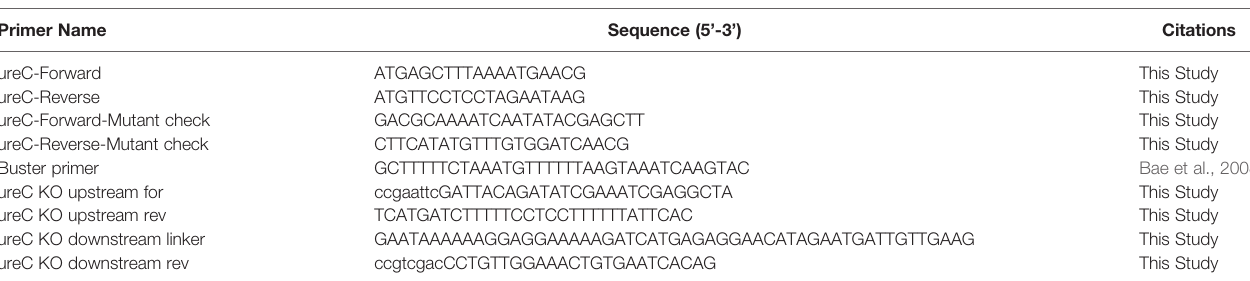
TABLE 2 | Primers used in this